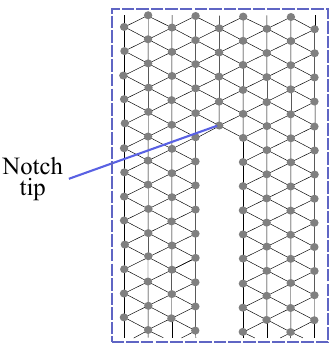
Figure 9. Representation of the lattice discretization near of the beam